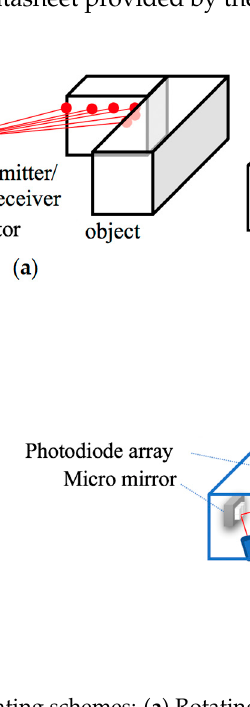
Figure 5. Operating schemes: ( a ) Rotating 2D LiDAR, ( b ) rotating 3D LiDAR, ( c ) solid state 3D LiDAR. The last kind of device based on laser measurement that has arrived in the autonomous vehicles world is the solid state LiDAR. Solid state LiDAR allows a 3D representation of the scene to be obtained around the LiDAR without the use of mobile parts in the device. A micro mirror MEMS circuit carries out the synchronization with a beam laser to scan the horizontal FOV in multiples lines.